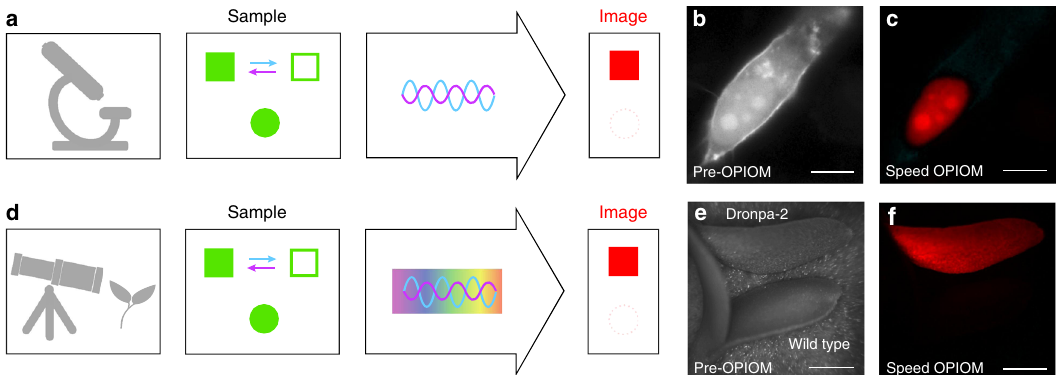
Fig. 3 Speed OPIOM selectively retrieves an RSFP signal in the presence of spectral interferences. In contrast to pre-OPIOM ( b , e ), speed OPIOM microscopy ( a ) and remote ( d ) imaging selectively unveils a RSFP target ( square in a , d , Dronpa-2 in c – f ) in cells ( a ) and Camelina seedlings ( d ) even in the presence of a spectrally interfering fl uorophore ( disk in a , d , EGFP in b , c ), auto fl uorescence or ambient light ( d ) and ( e , f ). Systems: Fixed HeLa cells expressing H2B-Dronpa-2 (at the nucleus) and Lyn11-EGFP (at the cell membrane). b , c Camelina, ubiquitously expressing Dronpa-2 or wild type (respectively top and down in e , f ). The images were recorded at 37 °C ( b , c ) and 20 °C ( e , f ). Scale bars ( µ m): 10 ( b , c ), 875 ( e , f ). See Supplementary